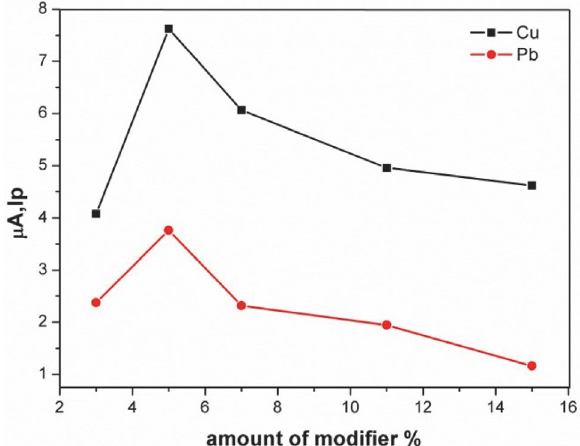
Fig. 6. Effect of amount of modifier on the stripping peak current for a solution containing 0.20 mol L −1 PBS (pH = 5), 1.0 × 10 −6 mol L −1 Cu(II) and 1.0 × 10 −6 mol L −1 Pb(II); deposition potential: −1.0 V vs. Ag/AgCl, deposition time: 300 s, resting time: 2 s, stirring rate: 300 rpm, scan rate: 0.1 V s −1